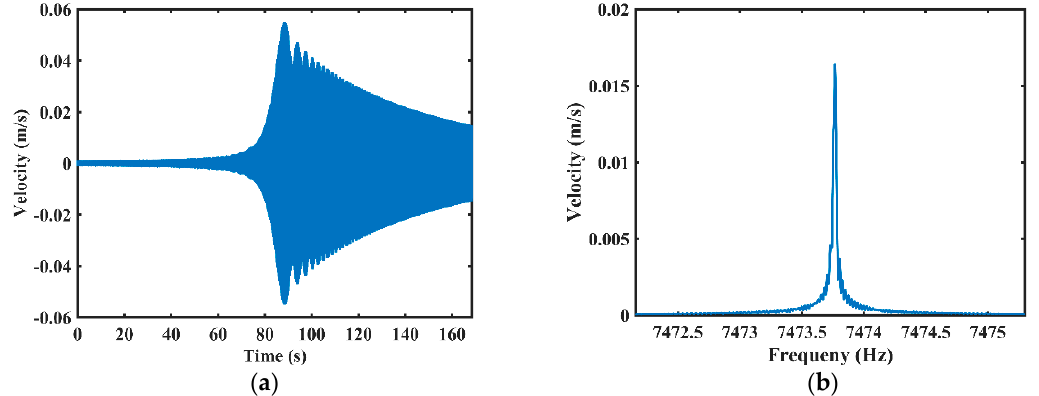
Figure 5. The results of the sweeping frequency detected by the laser Doppler vibrometer: ( a ) The vibration velocity detected by the laser Doppler vibrometer; ( b ) Fast Fourier transform (FFT) results of the vibration velocity.